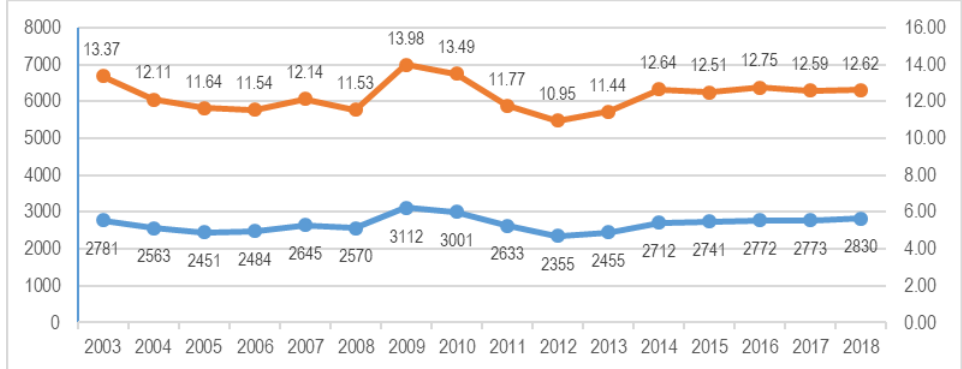
Figure 2. Incidence rate and total accidents recorded by men teachers from 2003 until